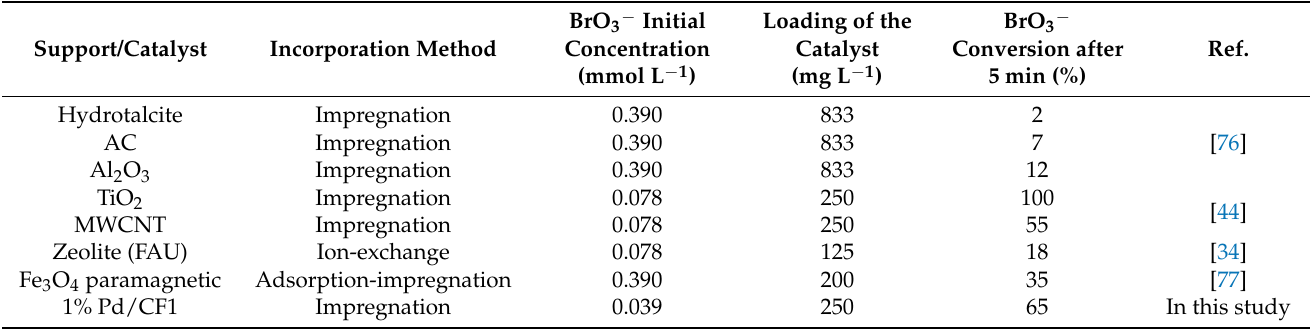
Table 5. Catalysts with a loading of 1 wt.% Pd used for BrO 3 − reduction in semi-batch